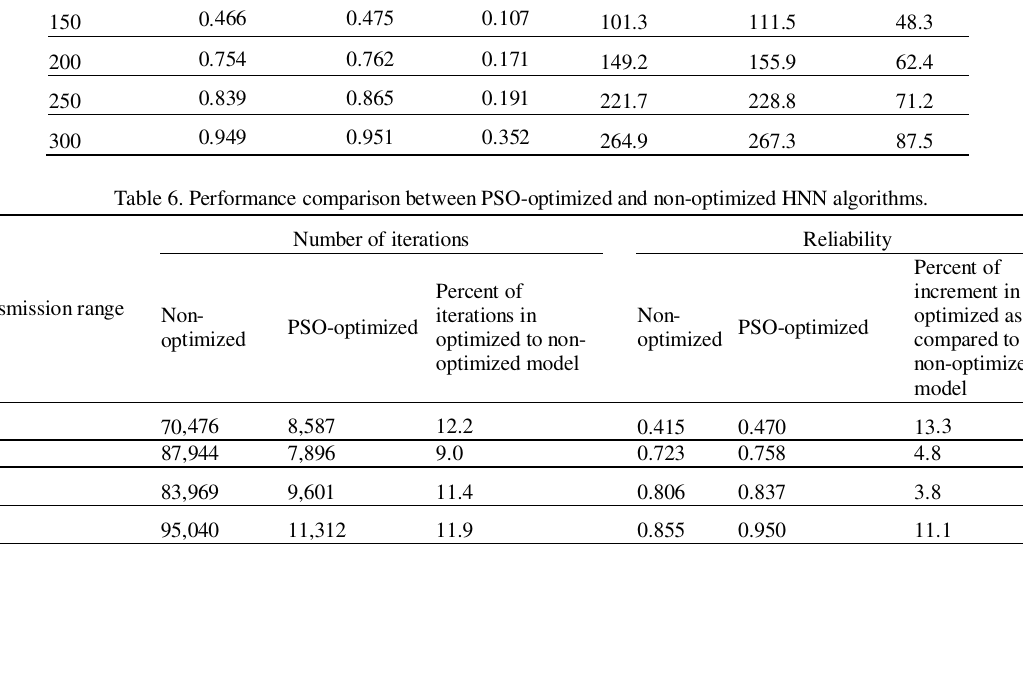
Table 5. Reliability and lifetime comparison between proposed algorithm and SP algorithm.